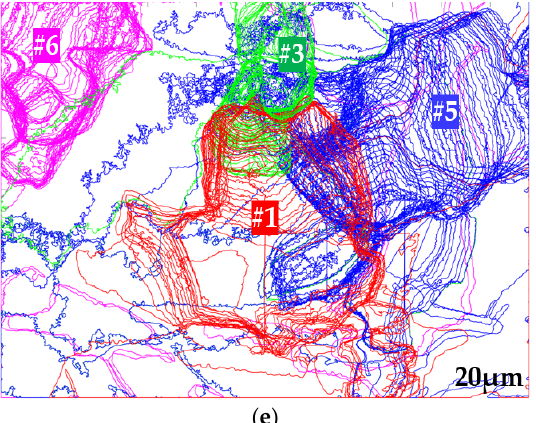
Figure 8. Stacking boundaries at each height. ( a ) Stacking of #1; ( b ) Stacking of #3; ( c ) Stacking of #5; ( d ) Stacking of #6; and ( e ) Top-view of stacking boundaries with four grains.